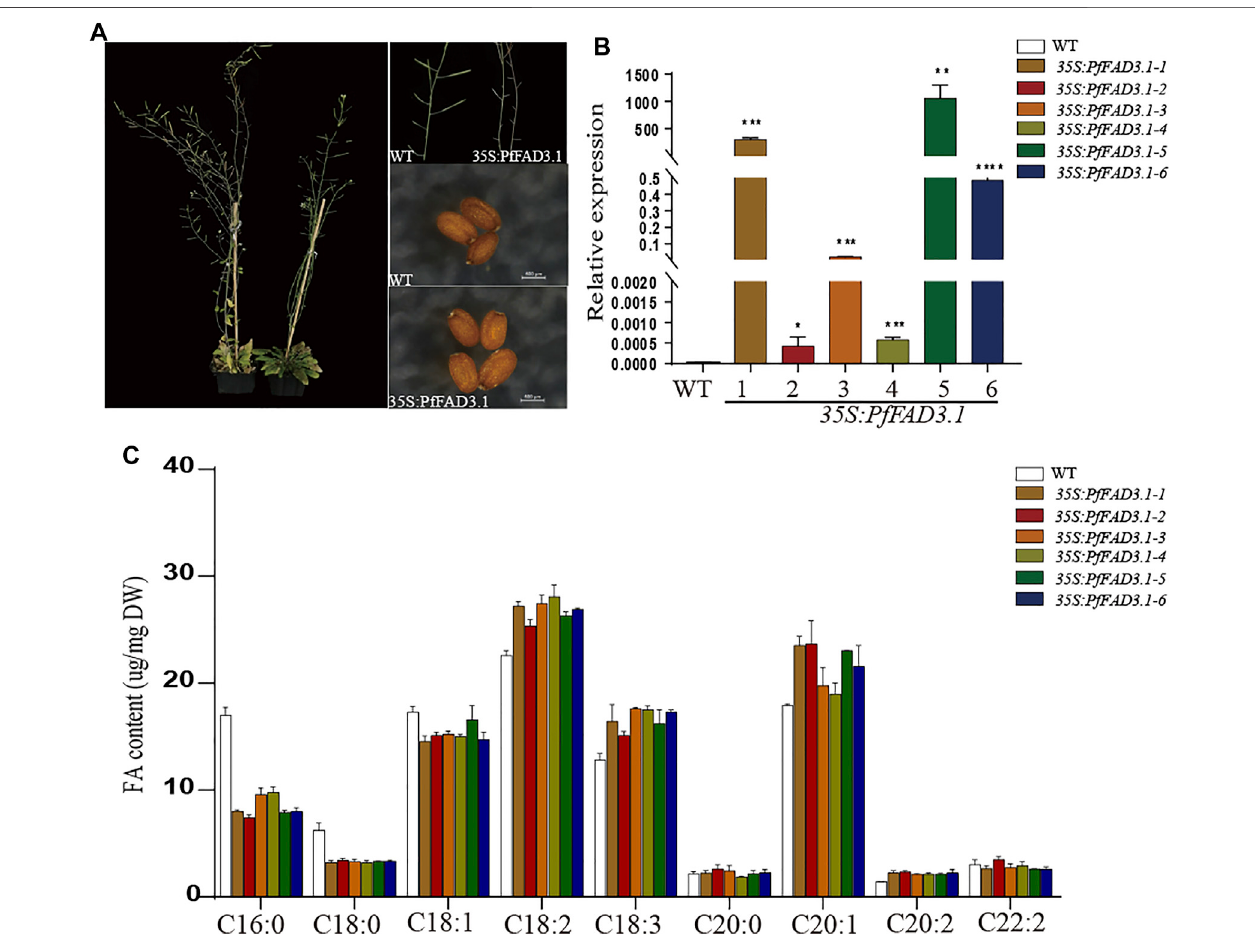
FIGURE 5| Effect oftransgenic PfFAD3.1 expression on FA composition in A. thaliana seeds. (A) Transgenic CaMV35S::PfFAD3.1 Arabidopsisplants and seeds. (B) The expression of PfFAD3.1 transgenic 35S::PfFAD3.1 Arabidopsis seeds determined by qRT-PCR. (C) FA composition in the seeds of transgenic 35S::PfFAD3.1 Arabidopsis. Error bars represent SD from at least three biological replicates. The asterisks indicate signi fi cant differences (* p < 0.05, Student ’ s t-test).